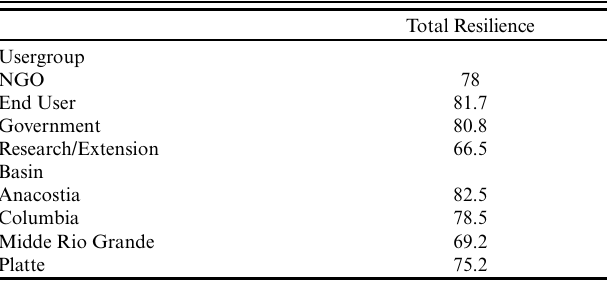
Table 2 . Total resilience scores by user group and